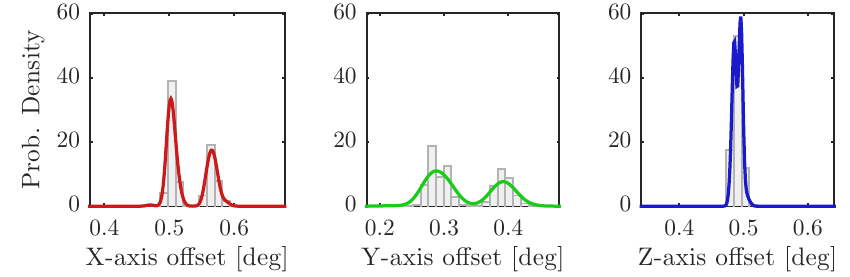
Figure 14. Calculated angular offset along the principal axes for 200 measurements of the pipe work-object using the inductive proximity probe (Sensor C).